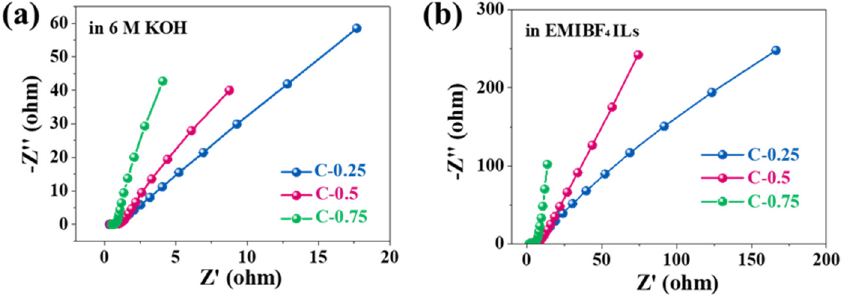
Figure 6. Electrochemical impedance spectroscopy (EIS) spectra of the samples tested in ( a ) 6 M KOH and ( b ) EMIBF 4 ILs.